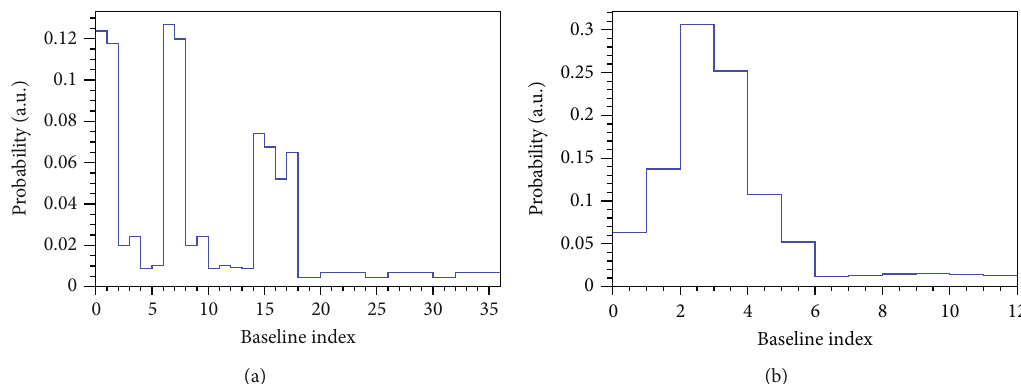
Figure 4: Baseline probability distributions for Daya Bay (a) and RENO (b), obtained from the simulation of 10 7 neutrino events. Histograms are normalized to unit